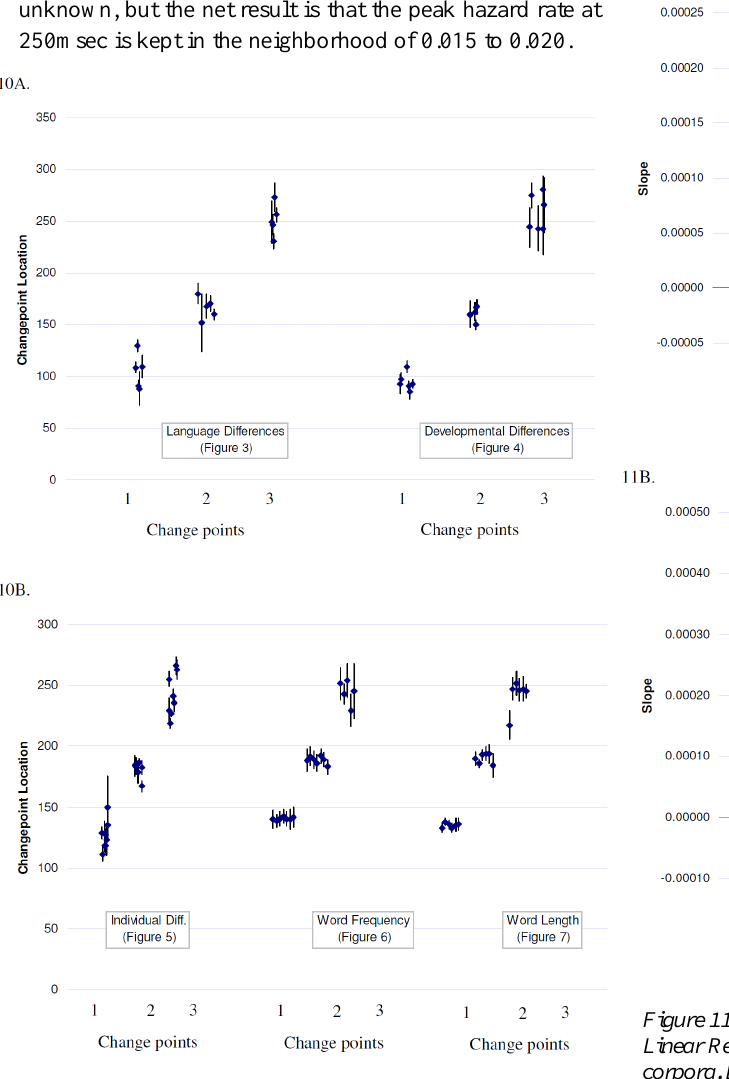
Figure 10A-B. Summary of Estimated Changepoint Locations. Panel A includes estimates based on different datasets. All estimates in Panel B are based on the Dundee corpus.